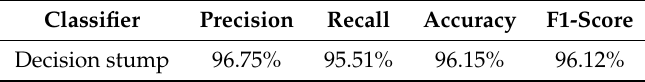
Table 6. Deceitful behavior detection based on the blink